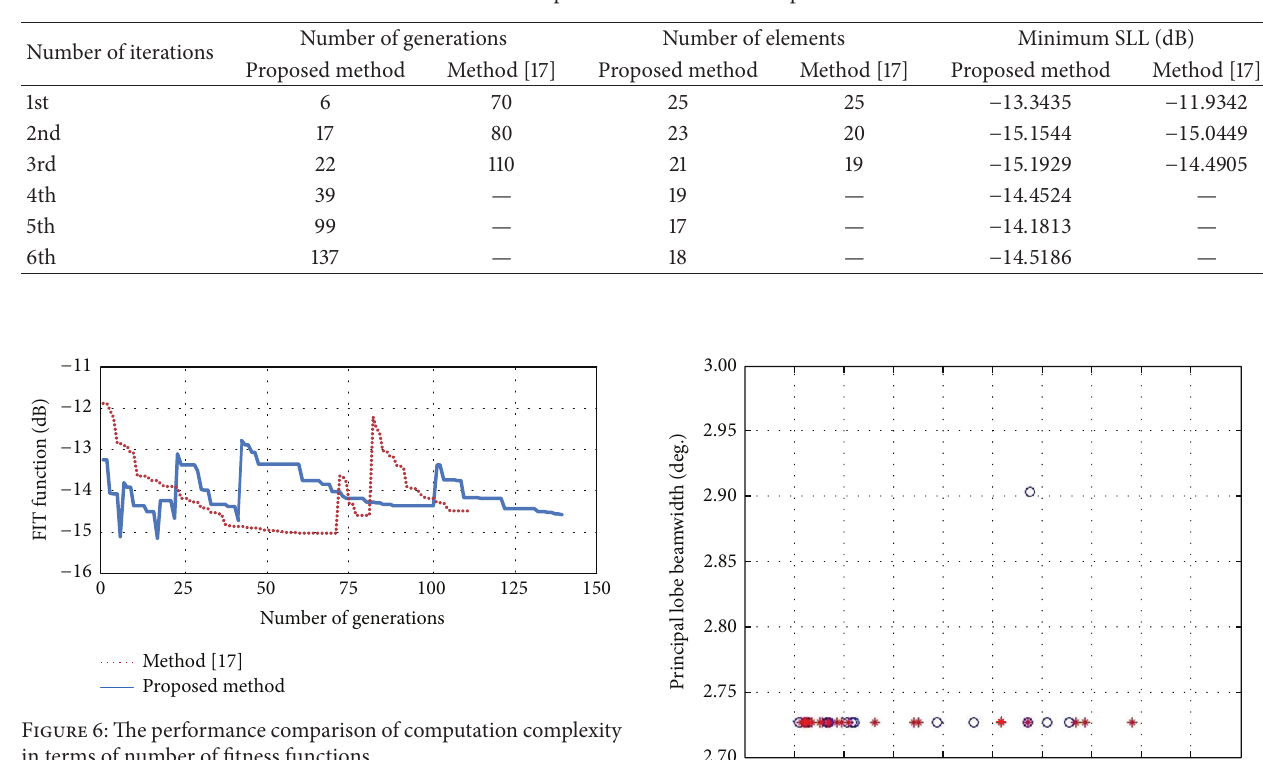
Table 3: Comparison results of iterative process.